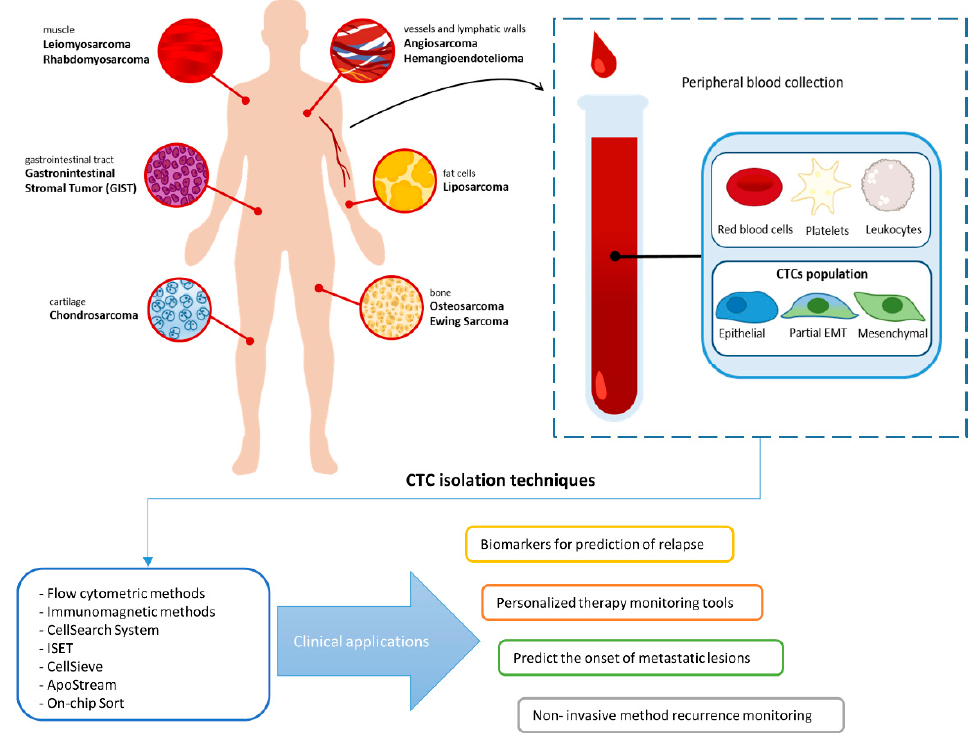
Figure 1. Technologies used to detect and isolate circulating tumor cells (CTCs) in sarcoma and their potential applications.